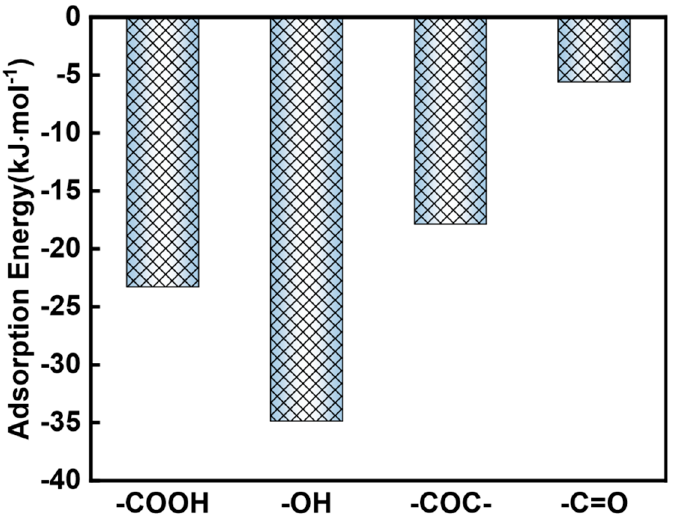
Figure 10. Adsorption energy of the iodine molecules and the oxygen functional groups in single-defect structure (D1), double-defects structure (D2) and triple-defects structure (D3).